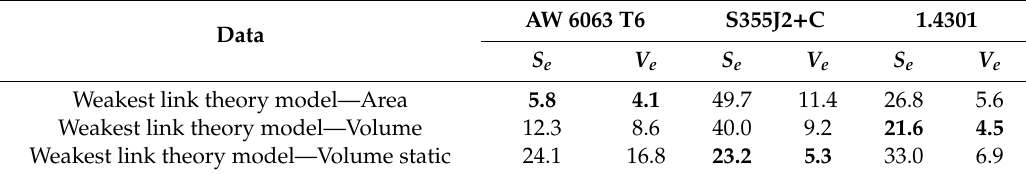
Table 9. Values of standard error of the estimate and the coe ffi cient of variation for the analytical